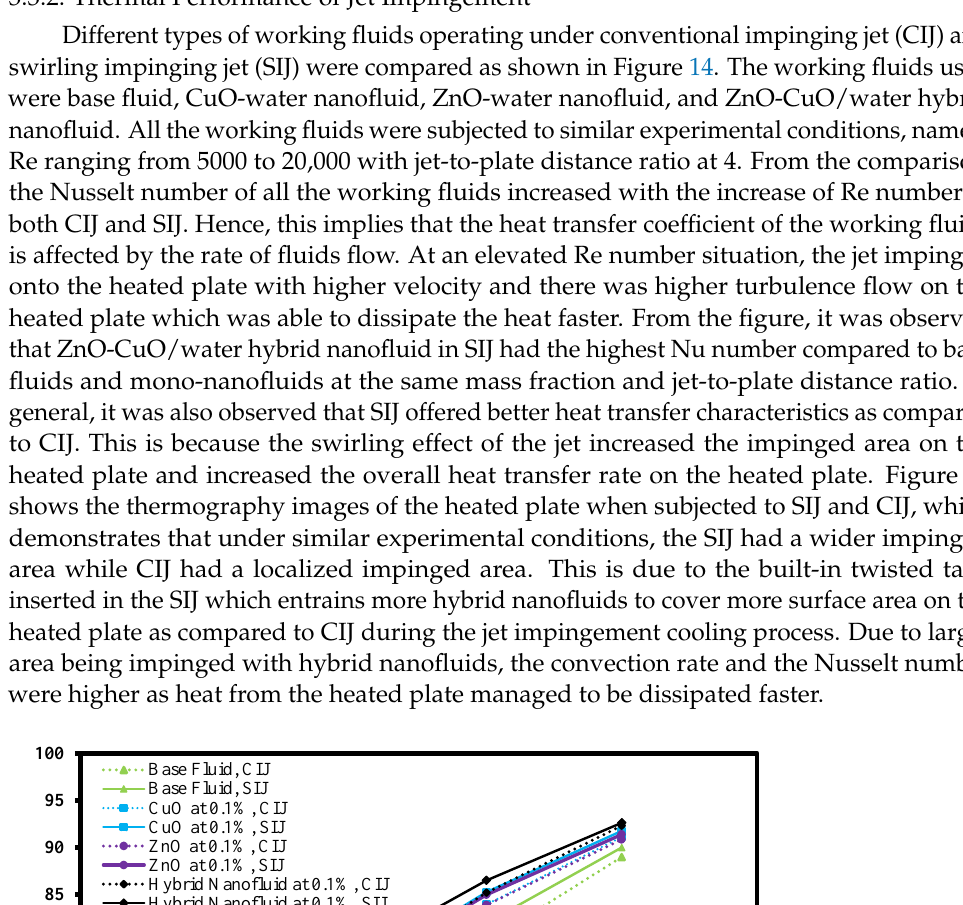
Figure 15. Thermographer images of ( a ) SIJ and ( b ) CIJ on heated plate .